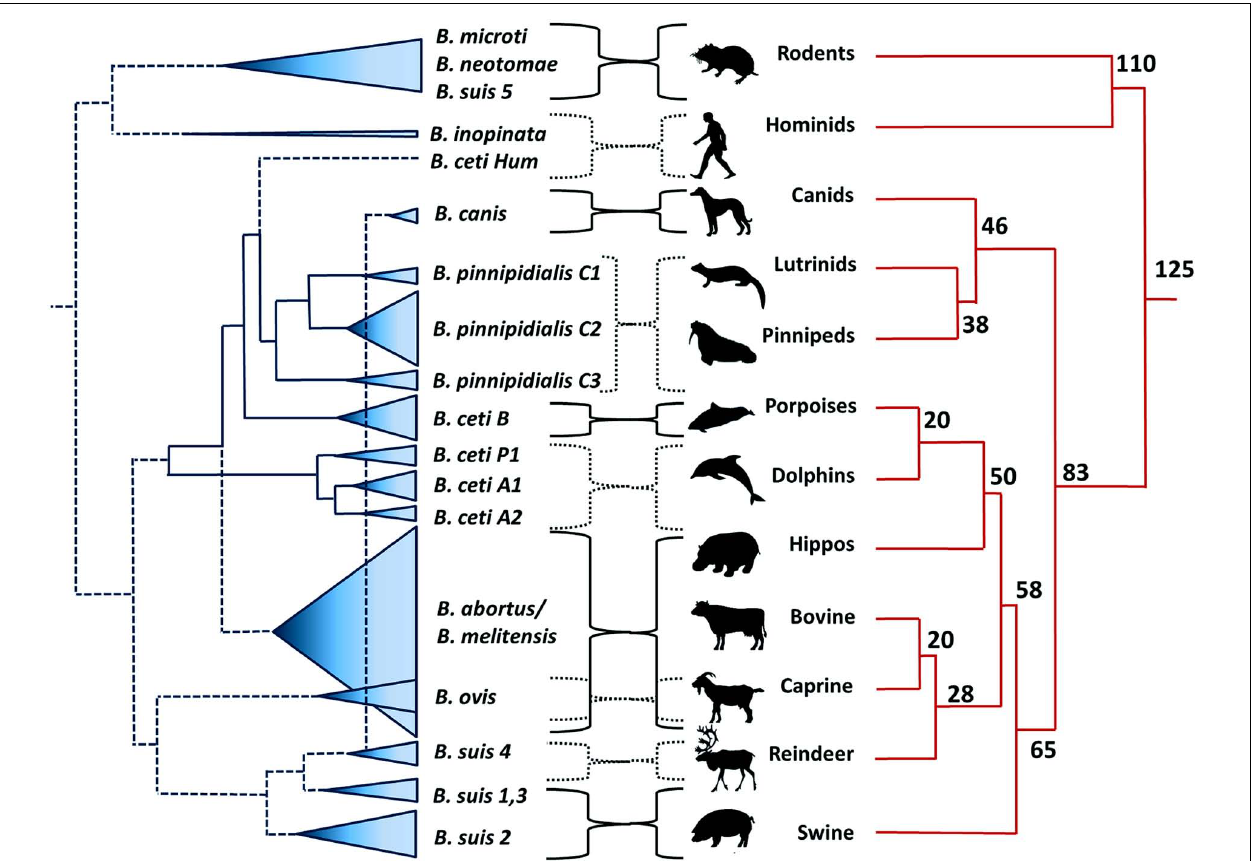
requires taxonomic definition.The source of the two isolates of B. inopinata is unknown. Notice that phylogenetic relationship between the two clades is not perfect suggesting that carnivore mammals acquire brucellosis (probably by depredation) after the initial dispersion of cetaceans and ungulates from an ancestral mesonychid, close to 65–60 million ya . Phylogenetic dendrogram was adapted from Guzmán-Verri etal.